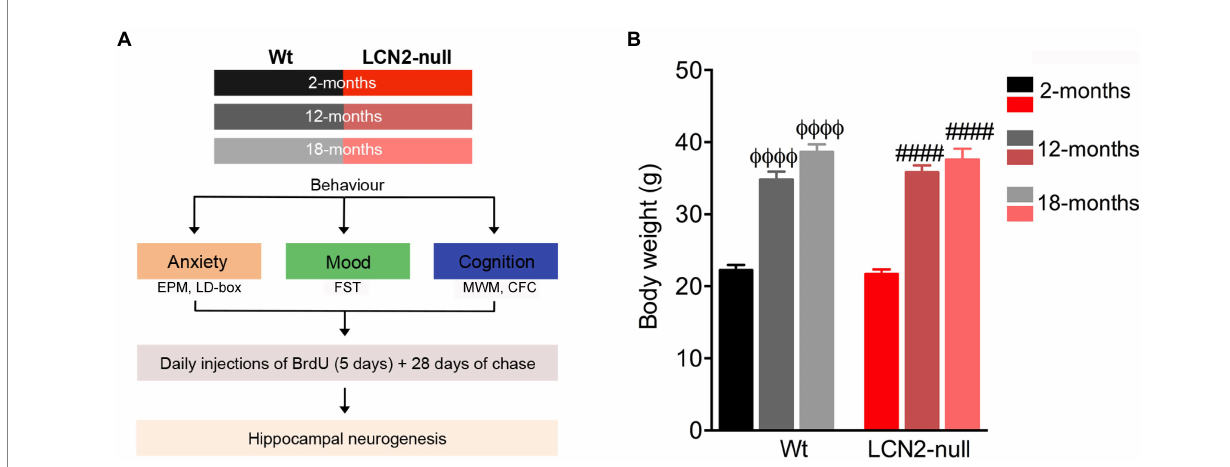
FIGURE 1 Body weight increases in aged animals, irrespectively of the genotype. (A) Schematic diagram of the experimental approach and the group of animals used at the respective ages. (B) Body weight measurements at selected ages revealed an age-related effect, with aged animals presenting increased body weight, when compared to genotype-matched 2-months old animals ( n = 10–12 mice per group). Data are presented as mean ± SEM, analyzed by two-way analysis of variance (ANOVA) with Bonferroni’s multiple comparison test. Φ Denotes differences between young and aged Wt; # between young and aged lipocalin-2 (LCN2)-null mice. ΦΦΦΦ , #### p ≤ 0.0001. EPM, elevated plus maze; CFC, contextual fear conditioning; FST, forced-swim test; MWM, Morris water